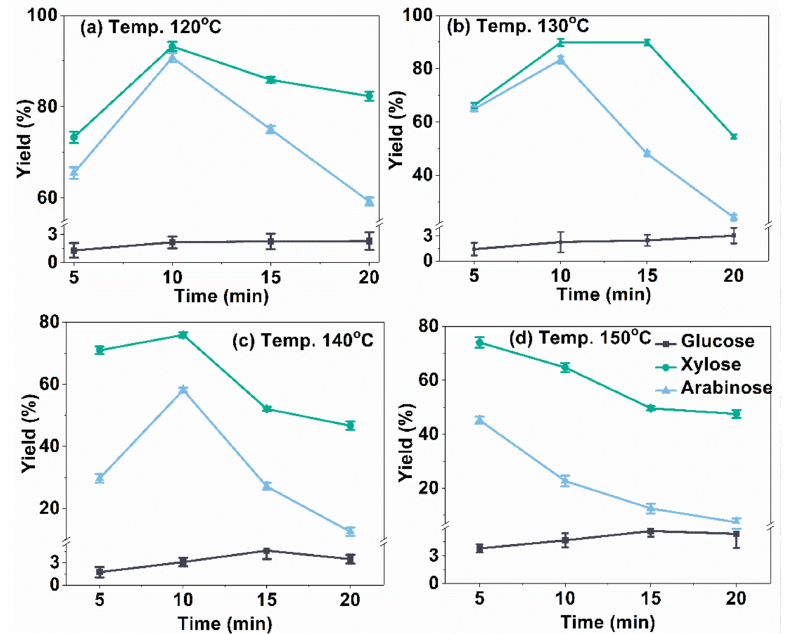
Figure 2. The effect of the reaction temperature and time on sugar yields (oxalic acid, 0.4 mol/L, solid–liquid ratio